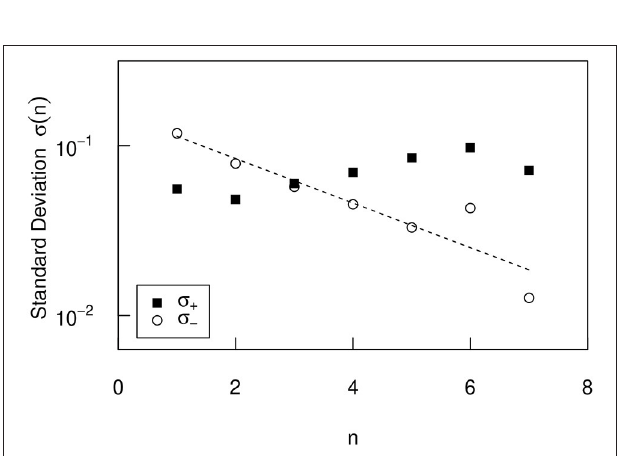
FIGURE 8 | The n dependence of the positive and negative standard deviations σ ± of the conditional PDFs in Spain.